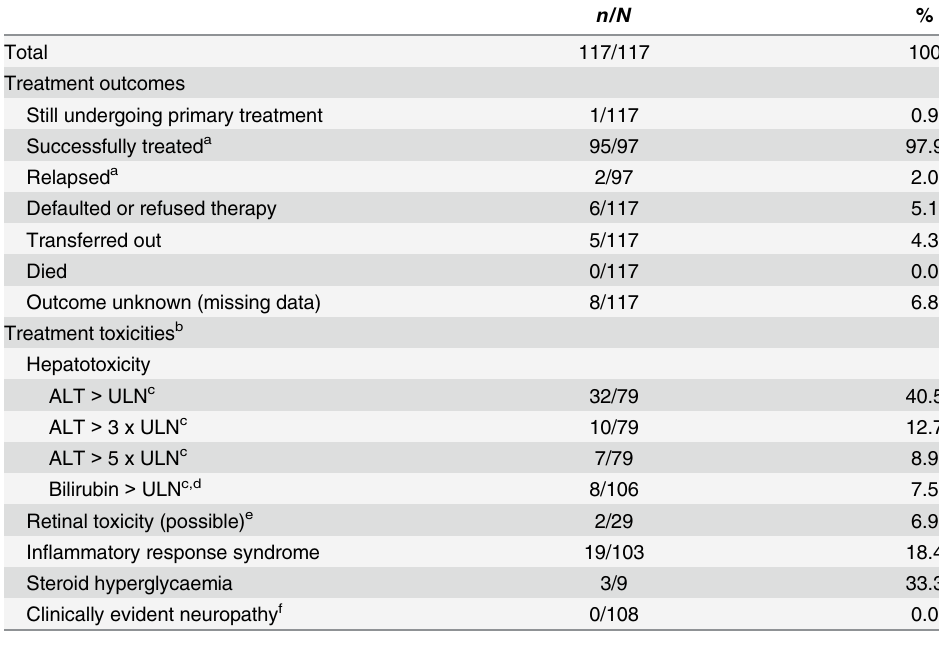
a Excluded defaulters, transfers and missing data b Denominator size excludes missing values c ULN = upper limit of normal, excludes those with elevated ALT pre-treatment d Excludes those with elevated bilirubin pre-treatment